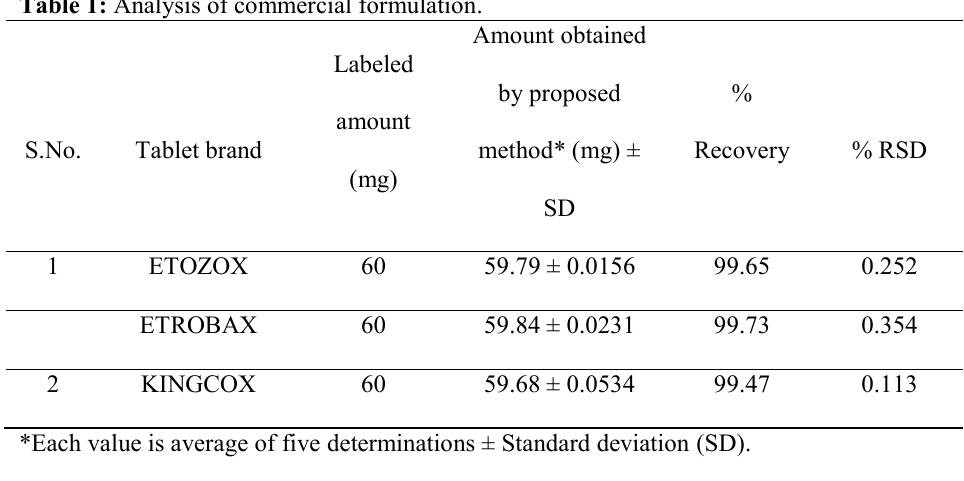
Table 1: Analysis of commercial formulation.